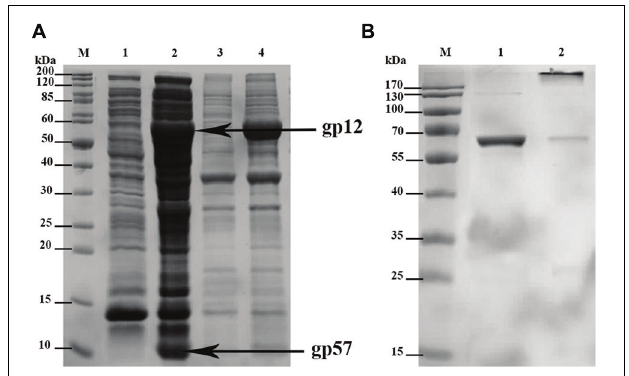
FIGURE 1 | SDS-PAGE of: (A) expressed recombinant His-tagged gp12 and gp57; overexpressed proteins are marked with arrows; M-molecular weight marker; 1-soluble fraction of the culture before induction (control); 2-soluble fraction of the culture after induction (expression); 3-insoluble fraction of the culture before induction (control); 4-insoluble fraction of the culture after induction (expression). (B) gp12 final preparation as trimeric and monomeric; M – molecular weight marker; 1 – heated gp12 (denatured protein) as monomeric (57.5 kDa); 2 – non-heated gp12 as trimeric (172.5 kDa).